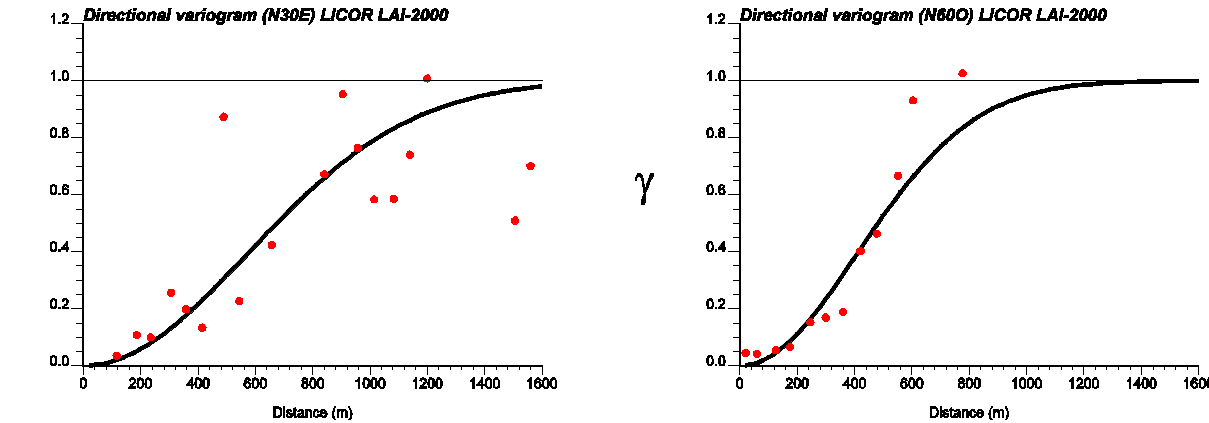
Figure 5 . Gaussian models fitted to the directional variograms derived for the maximum (left) and minimum (right) anisotropy directions observed from the LAI measurements.